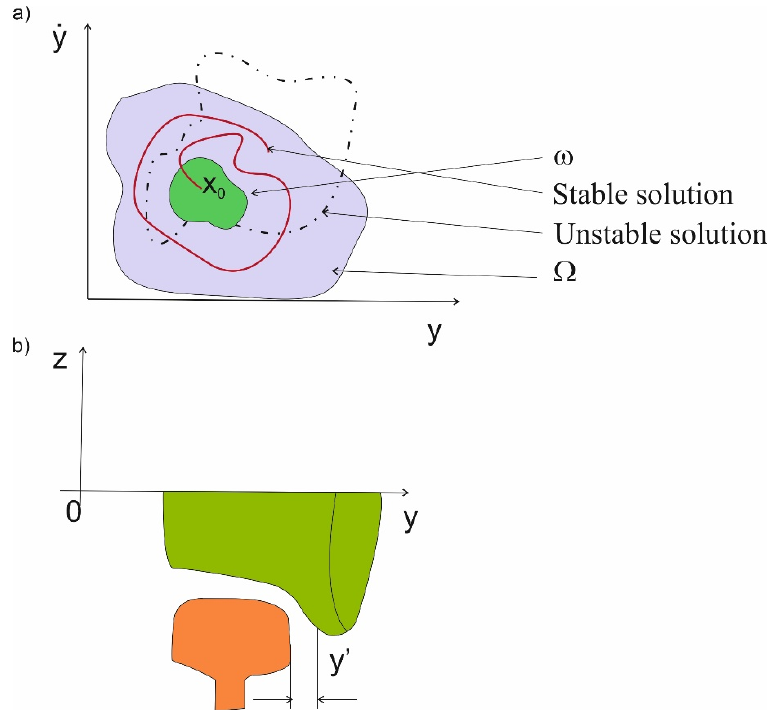
Figure 1. Graphical interpretation of the stochastic technical stability in the wheel–rail system ( a ) STS phase plane, ( b ) the wheel–rail system.